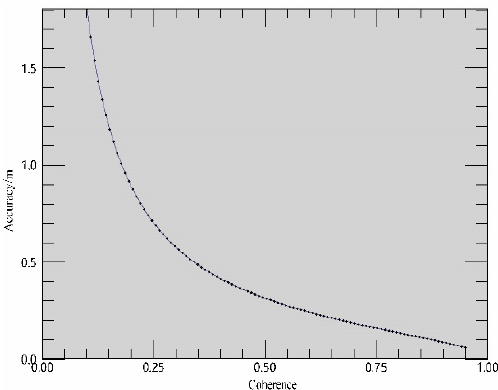
Figure 8. Relationship diagram between Sentinel-1 deformation accuracy and coherence.